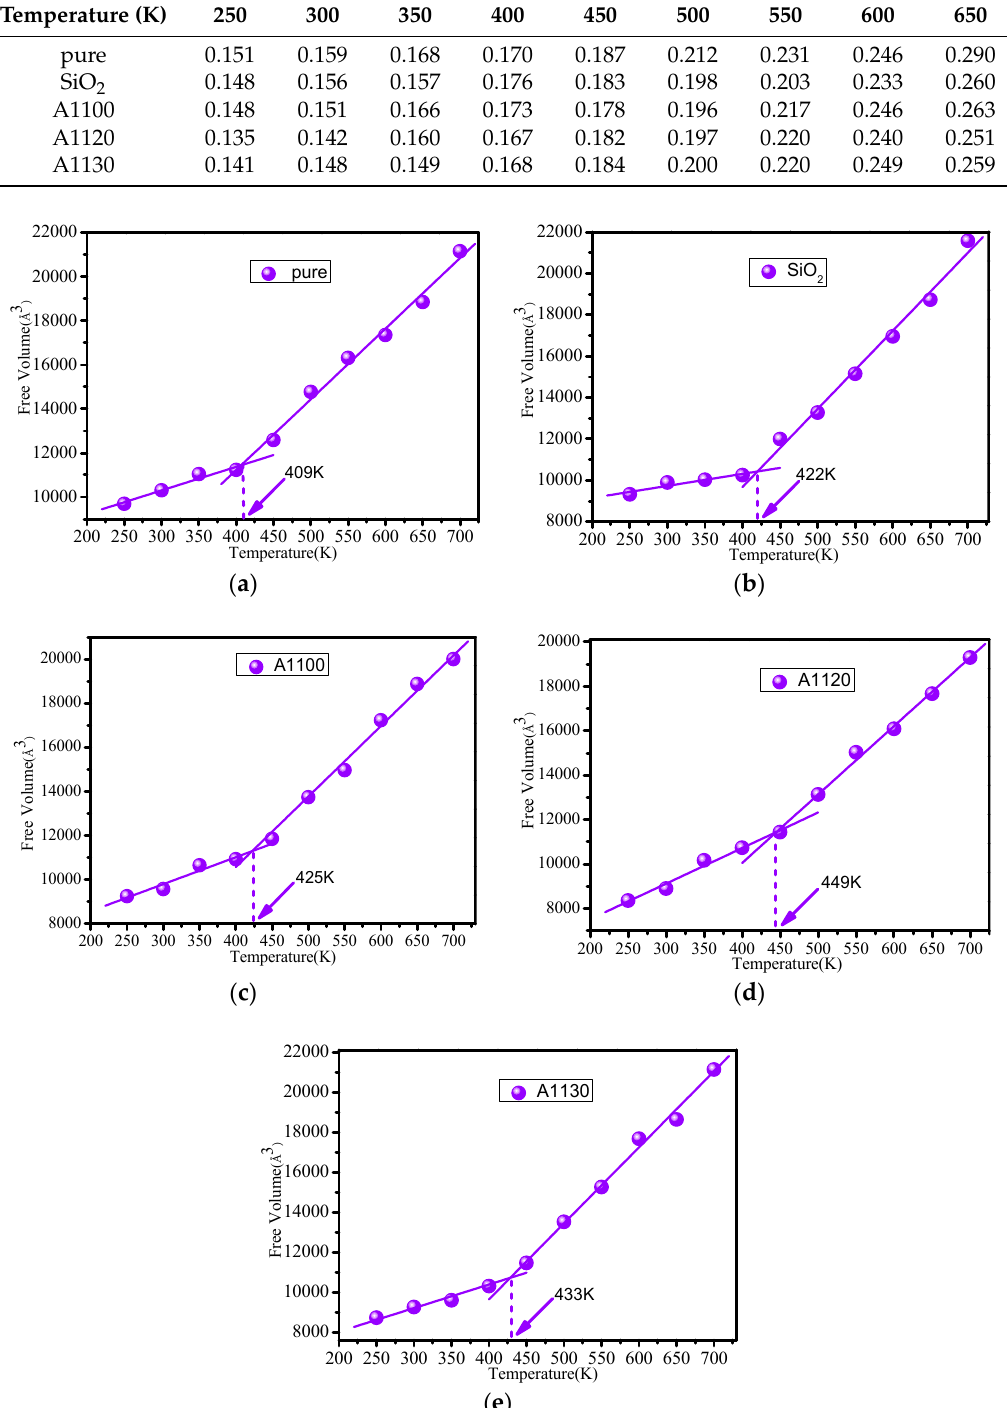
Figure 9. ( a ) Free volume-temperature fitting curve of pure epoxy resin model; ( b ) free volume-temperature fitting curve of SiO 2 model; ( c ) free volume-temperature fitting curve of A1100 model; ( d ) free volume-temperature fitting curve of A1120 model; ( e ) free volume-temperature fitting curve of A1130 model.